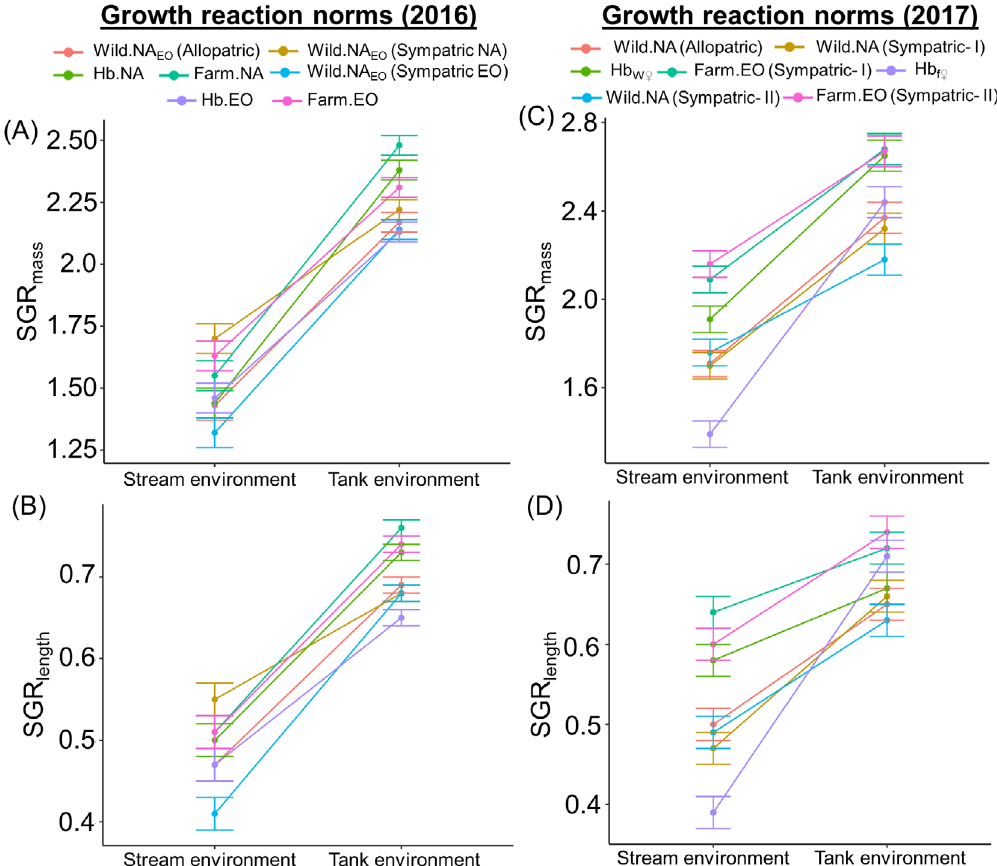
Fig. 5. (A−D) Growth reaction norms of Atlantic salmon between environments (tank environment with pellet feed; stream en- vironment with semi-natural feed) among cross types in 2016 and 2017 experiments. Displayed are marginal means ±SE. The axes differ between panels. See Fig. 2 for cross